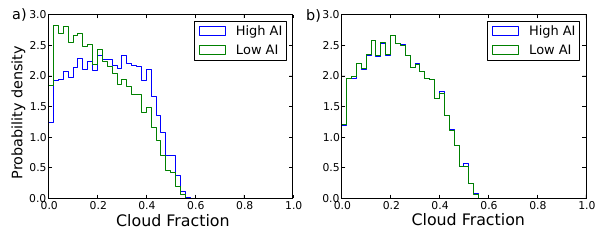
Fig. 1. The shallow cumulus regime cloud fraction (CF) distribution for low and high AI populations. Before accounting for CF varia- tions (a) , there is a strong link between AI and CF, afterwards (b) , this link is reduced. We also correct for 500hPa vertical velocity, low troposphere static stability, 850hPa relative humidity and 10m windspeed. This step is performed for each regime, separately over land and